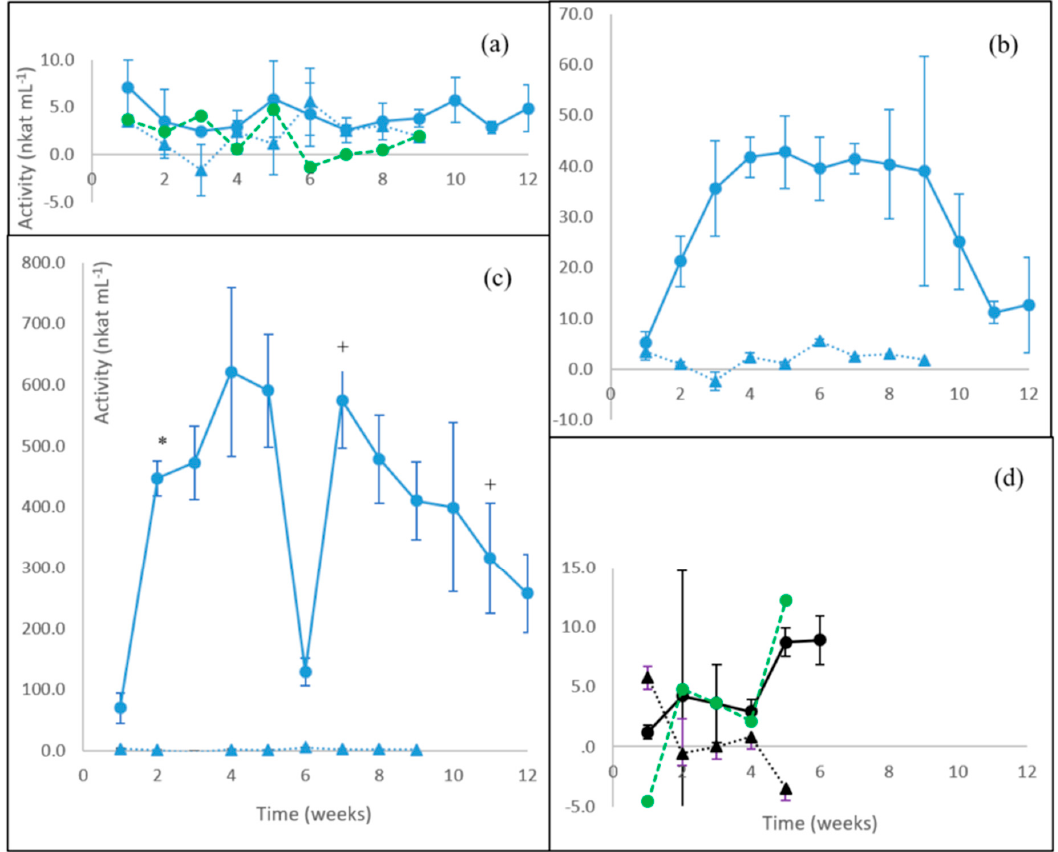
Figure 5. Xylanase activities produced by ( a ) the WR fungus P. radiata ; ( b ) the BR fungus F. pinicola ; ( c ) the GR fungus S. commune ; and ( d ) the LDF species C. cinerea . Fungal cultivations on birch wood (blue line with spheres) and on barley straw (black line with spheres). Values from control incubations of birch wood (blue triangles) and barley straw (black triangles) without fungi are included. ( a , d ) Net activity values are also shown (green dotted lines) after subtracting the control activity. Mean value ( n = 3) is presented at each week time point. Bars indicate the standard error. Notice different scales in the y axis. *, + statistically significant changes between time points. For information on the fungi, see Table 1.